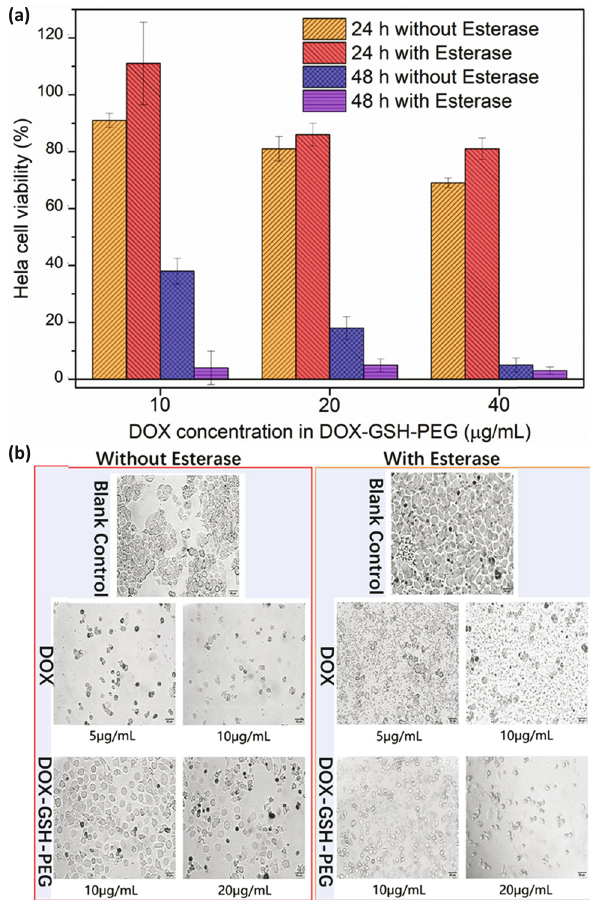
Figure 5: ( a ) The Hela cell viabilities treated with DOX - GSH - PEG during 24 and 48 h and ( b ) the cells ’ status imaged by di ff erent concentrations of DOX and DOX - GSH - PEG with or without esterase at 48 h ( scale: 20 ×)